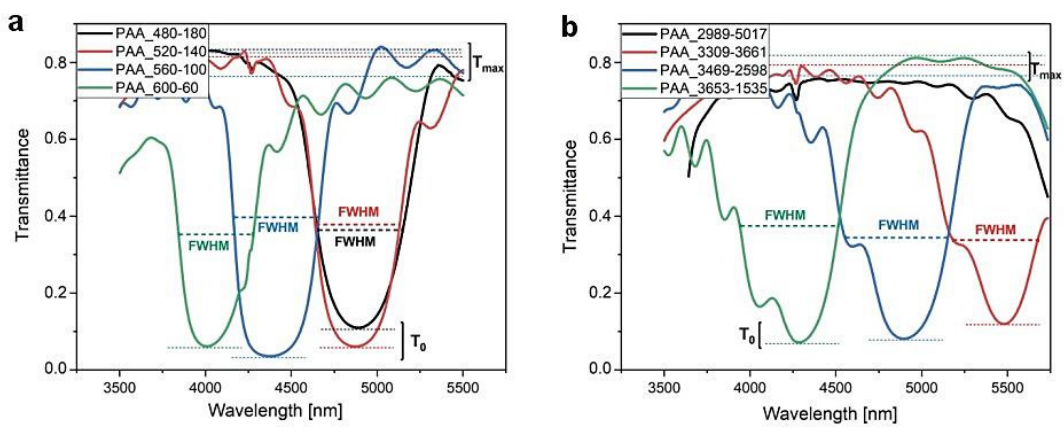
Figure 8. The λ 1 peaks in the PAA-based DBRs anodized under ( a ) time-controlled mode and ( b ) charge density-controlled mode. Table 1. Transmittance at λ 1 central position (T 0 ) and the full width-half maximum (FWHM) of the λ 1 peak determined for the PAA_t L -t H and PAA_C L -C H DBRs.